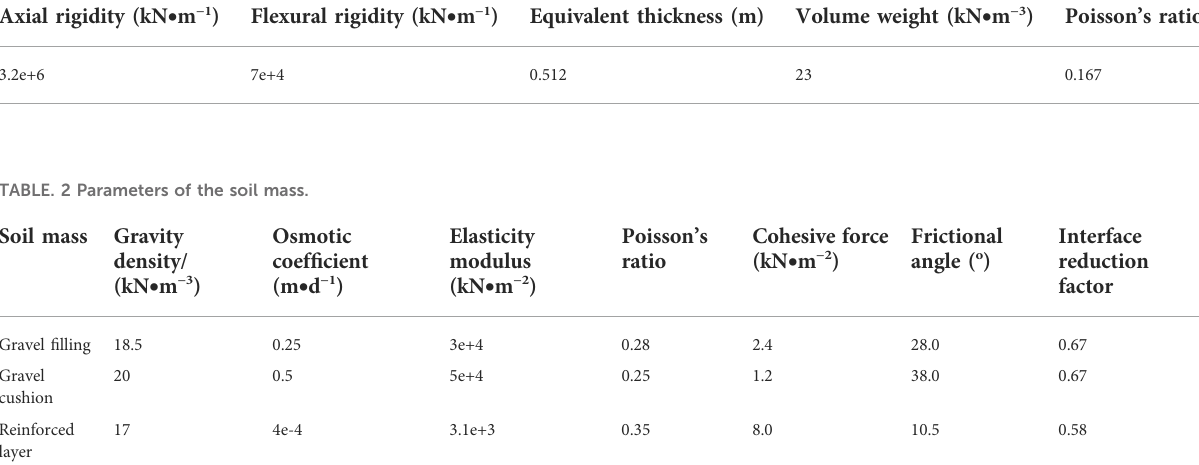
TABLE 1 Mechanical parameters of CFG pile.